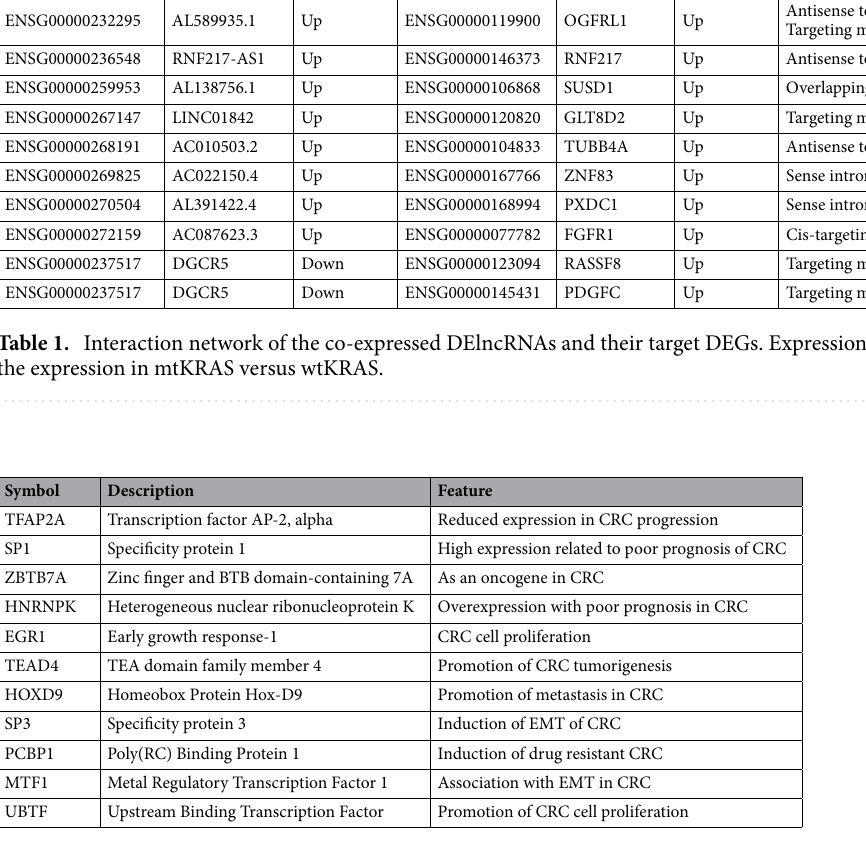
Table 2. List of TFs regulating the identified DEGs using Enrichr Tool through scanning the TRANSFAC and JASPAR databases.